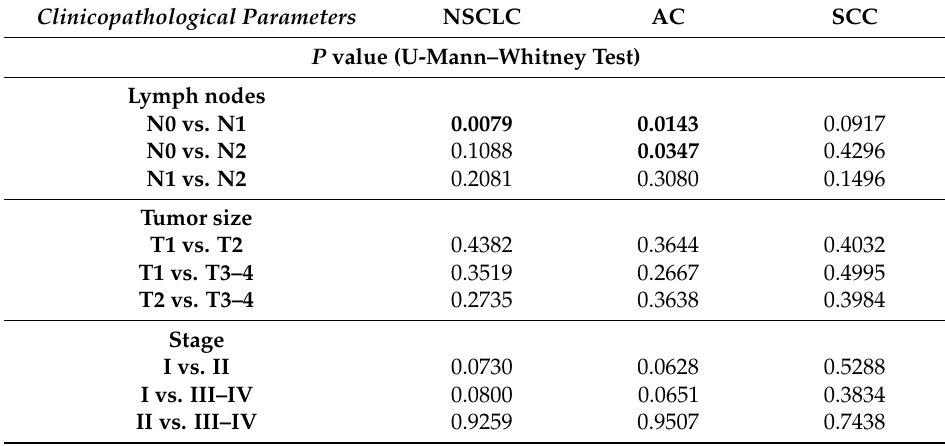
Table 2. Associations of PD- L1 expression level with clinicopathological characteristics in patients with NSCLC.